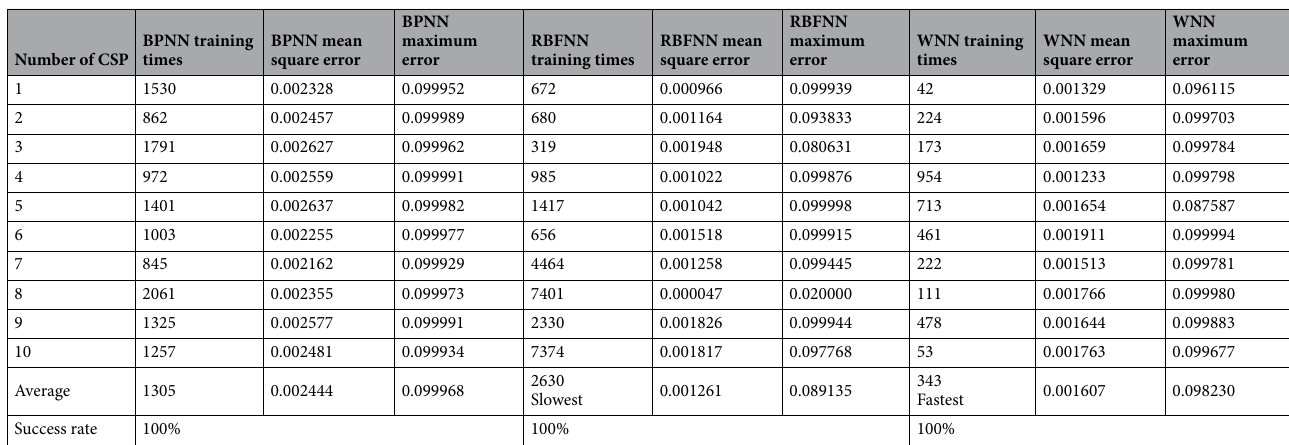
Table 1. Simulation results of "Feasibility